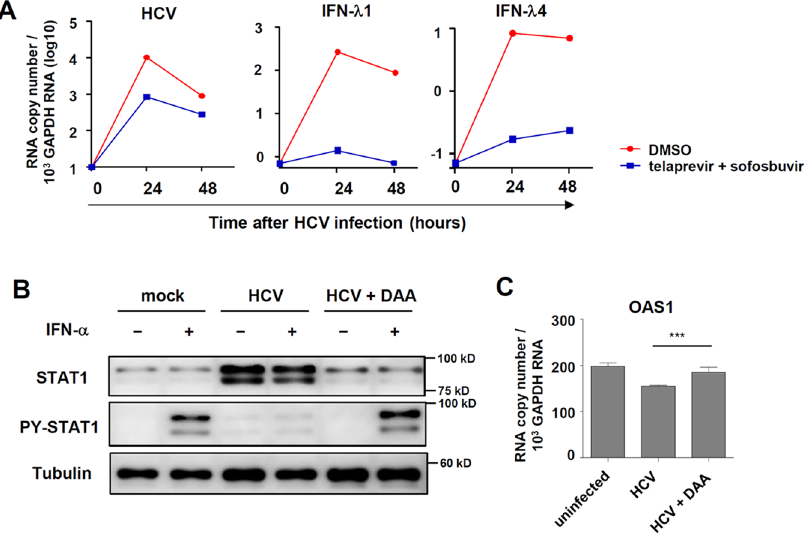
Figure 2. HCV infection results in IFN- λ 4 expression and IFN- α unresponsiveness that is restored by DAA treatment. ( A ) PHHs were infected with JFH1 HCVcc at 2 MOI. Shortly after HCV infection, telaprevir (5 μ M) plus sofosbuvir (5 μ M) were added to HCV-infected cells. After 24 or 48 hours, the cells were harvested, and gene expression was analysed by real-time qPCR. ( B ) PHHs with the IFNL4 Δ G/ Δ G genotype were infected with JFH1 HCVcc at 2 MOI. Six hours after HCV infection, the culture medium was changed to the medium containing telaprevir (5 μ M) and sofosbuvir (5 μ M). After 120 hours, the cells were treated with 100 IU/ml of IFN- α for 30 minutes ( B ) or 6 hours ( C ). The cells were harvested, and gene and protein expression were analysed by immunoblotting ( B ) or real-time qPCR ( C ). Data are presented as means ± S.E.M. *** P ≤ 0.001 (Student’s t-test). DAA: direct-acting antivirals. All the data are representative of two independent experiments. Full-length blots of PY-STAT1 ( B ) with multiple exposure times are included in the Supplementary Fig. 9B. The data are representative of three independent